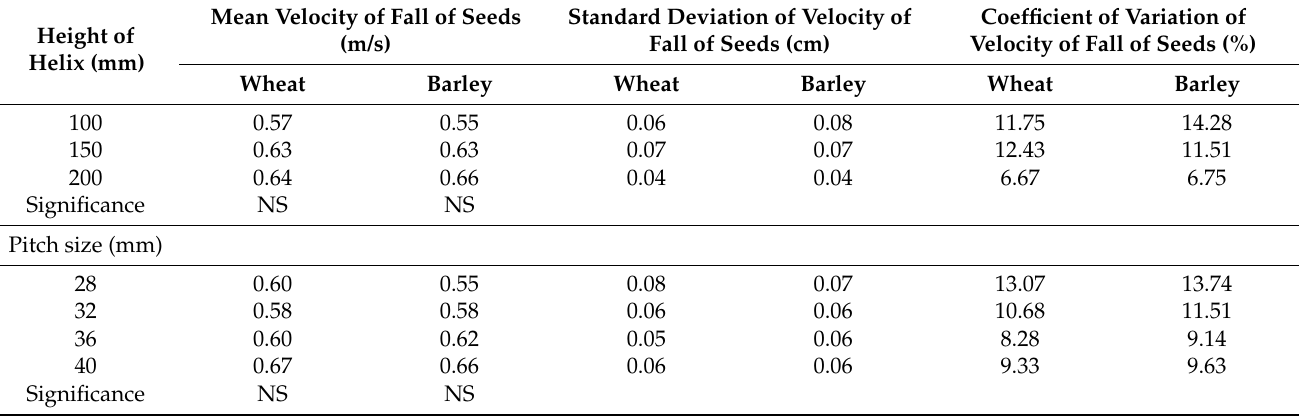
Table 5. The effect of the height of helix and pitch size of helicoidal seed tube on the mean velocity of fall of seeds, standard deviation, and coefficient of variation of velocity of fall of seeds, according to results of laboratory